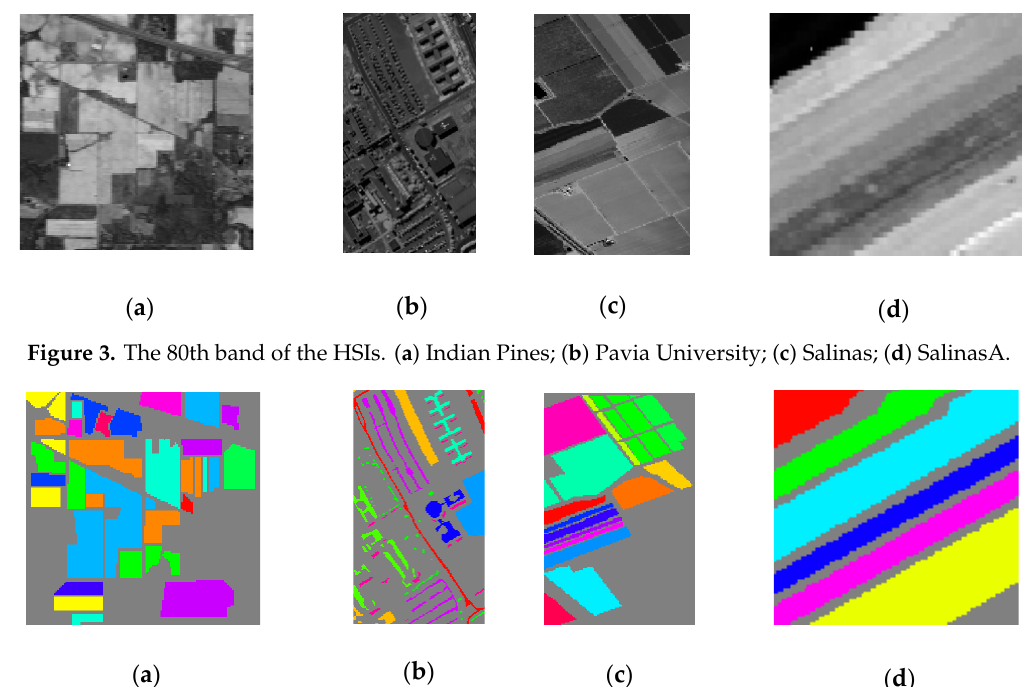
Figure 4. Color labels for the classes. ( a ) Indian Pines; ( b ) Pavia University; ( c ) Salinas; ( d ) SalinasA.